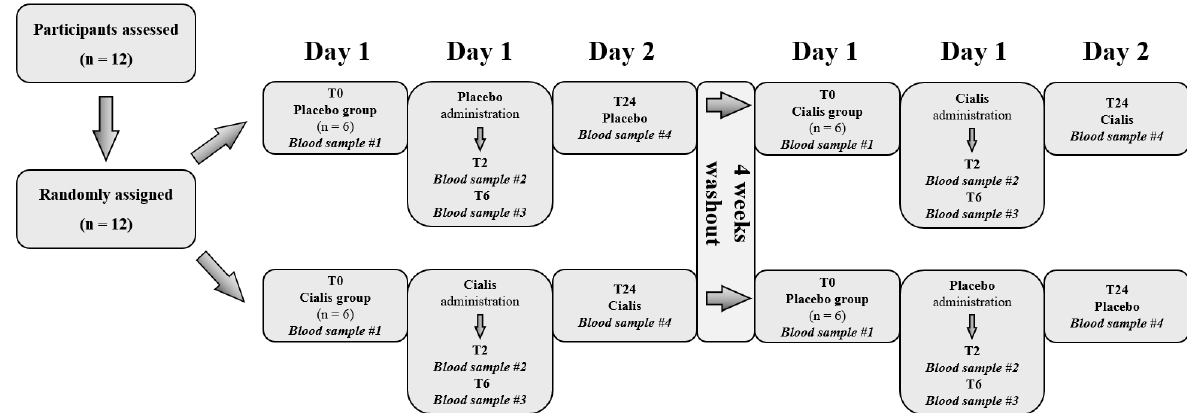
Figure 1. Flow diagram of the study. Twelve subjects were selected and then randomly assigned to the Cialis group (n = 6) or to the placebo group (n = 6) (Day 1). Then, subjects were given either Cialis (one tablet) or the placebo. Blood collections were performed at baseline (T0), and 2, 6 and 24 hours (Day 2) after administration (T2-T6-T24). After 4 weeks of washout, in the second experimental session, the volunteers were switched, and received either the placebo or Cialis, respectively. Each subject was his own control.